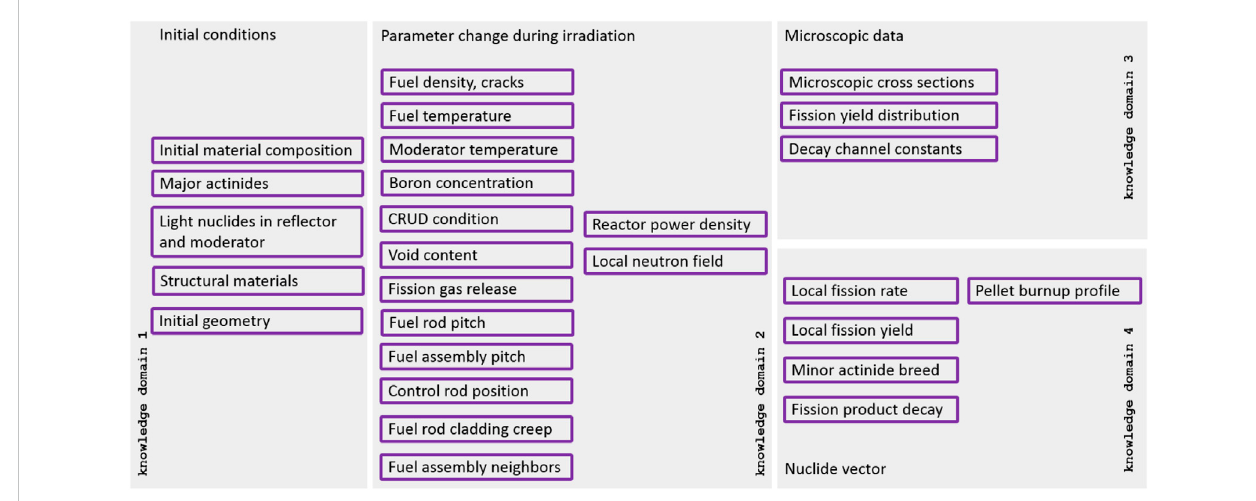
FIGURE 3 Factors in fl uencing accuracy of source term determination for commercial nuclear